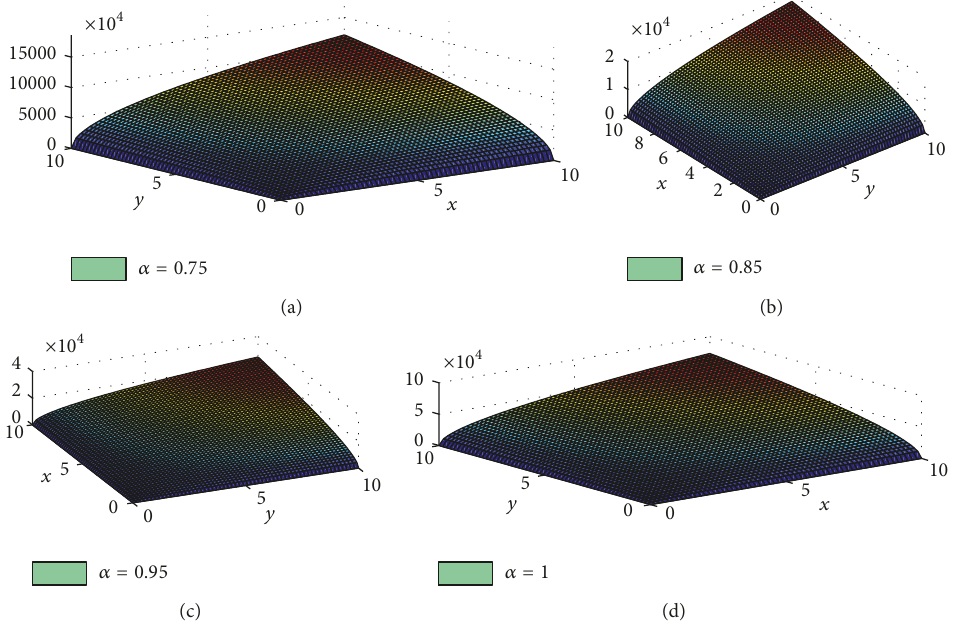
Figure 3: Numerical plots of approximate solutions of Example 8 at various fractional orders and using 𝑘 = 0.1, 𝑡 =